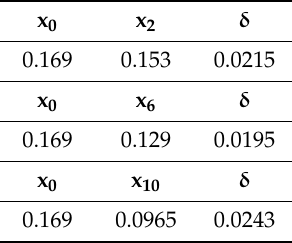
Table 15. Coe ffi cient of frictional torque calculation